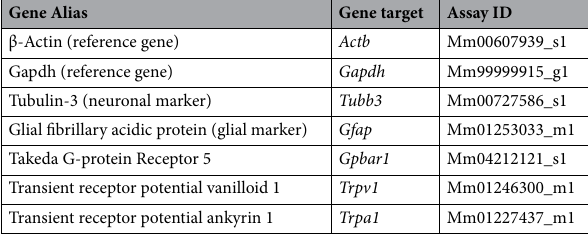
Table 2. Primers used for qRT-PCR receptor expression